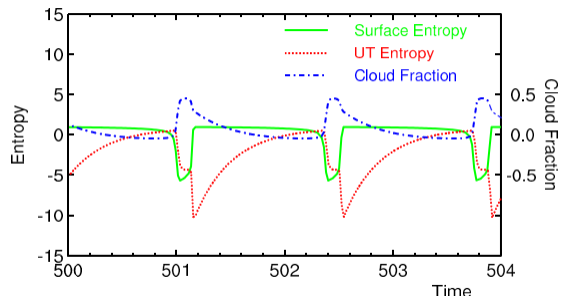
Figure 11. Time series of (green) the dimensionless surface entropy X, (red) the UT entropy Y and (blue line) the UT cloud fraction Z in the system of Equations (18)–(20) (see Appendix A for the definitions and parameters used). The horizontal axis of time is scaled with 2 τ t = 28 days (or ~ 1 month) as the unit.